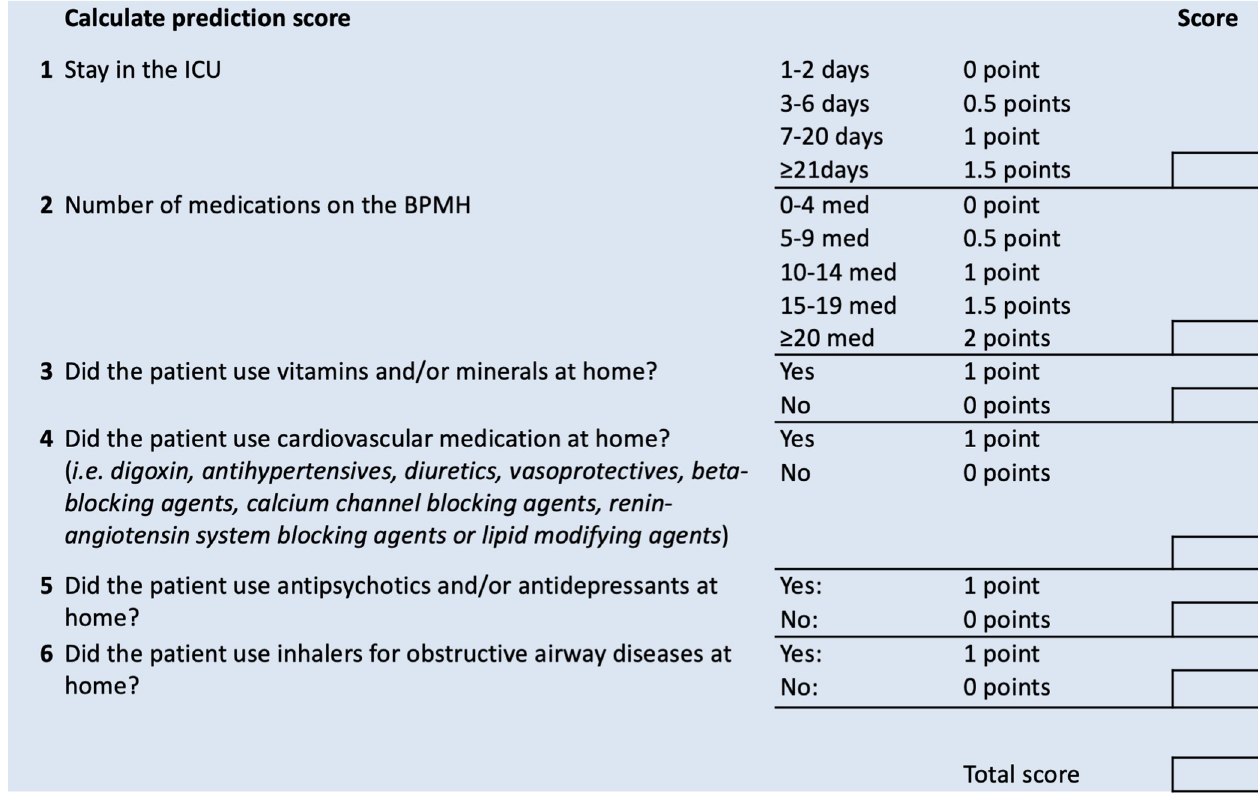
Fig 3. Patient’s prediction score calculator for potential harmful medication transfer